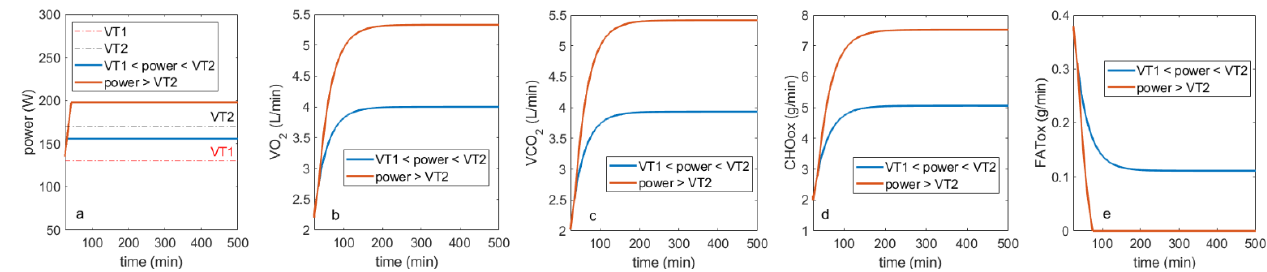
Figure 3. Simulation of projected patterns of relative nutrient consumption for when ( a ) simulated effort persists between VT1 and VT2 (blue), or is above VT2 (red), and corresponding ( b ) projected VO 2 , ( c ) VCO 2 , and ( d ) calculated levels of carbohydrate and ( e ) fatty acid oxidation.